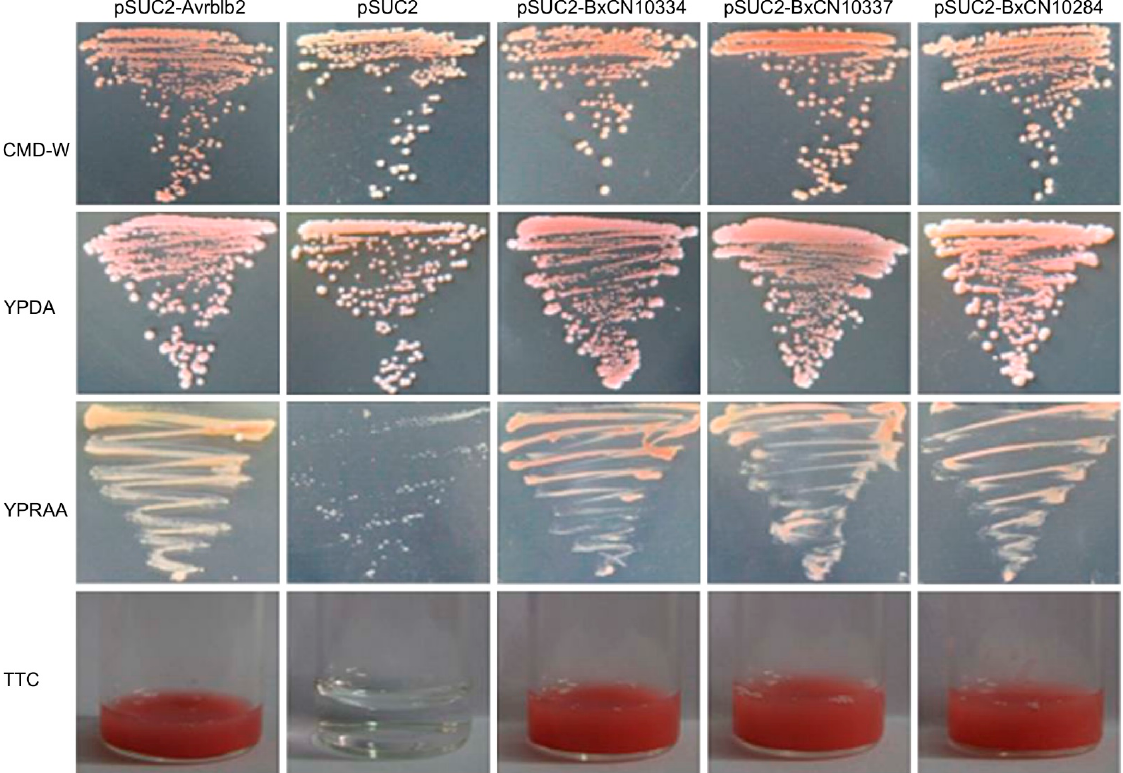
(BxCN10334, BxCN10337, and BxCN10284) were inserted into the plasmid